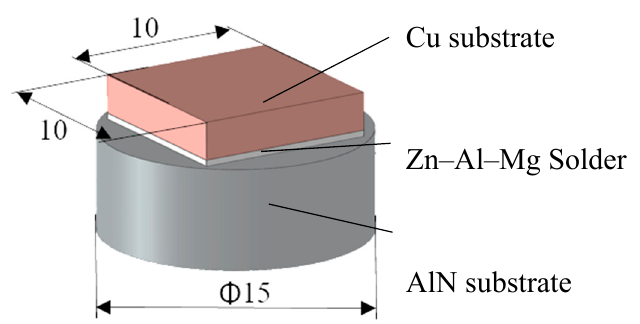
Figure 4. Specimen for shear testing the Cu/Zn–Al–Mg/AlN joint. Unit: mm.